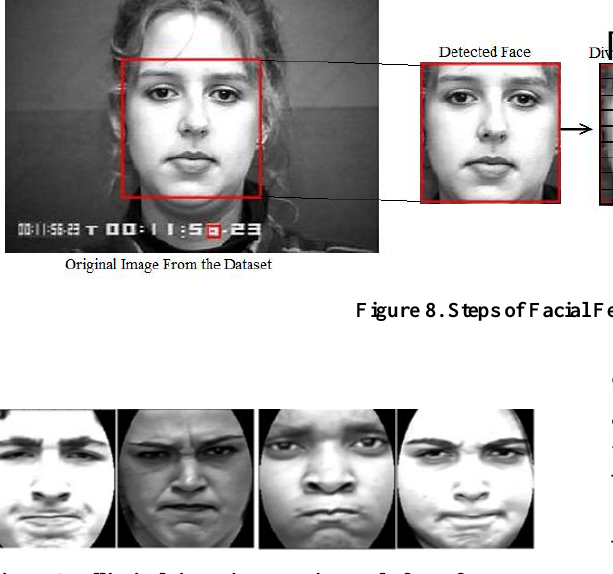
Figure 9. Elliptical shaped cropped sample faces from CK+ dataset.